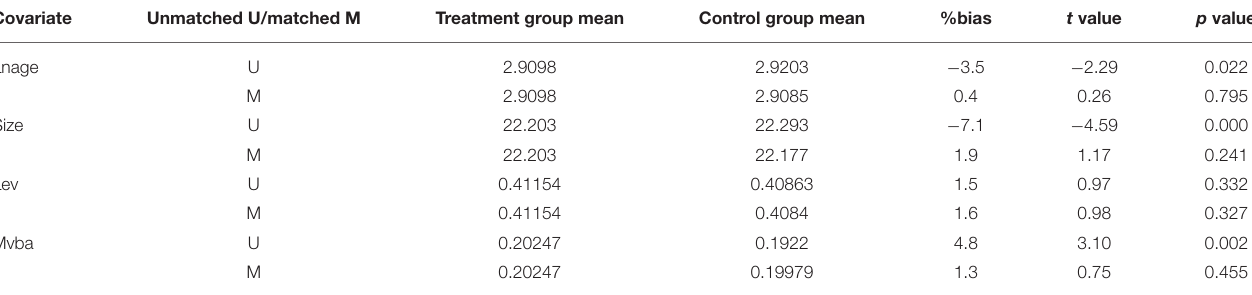
TABLE 7 | Balancing assumption